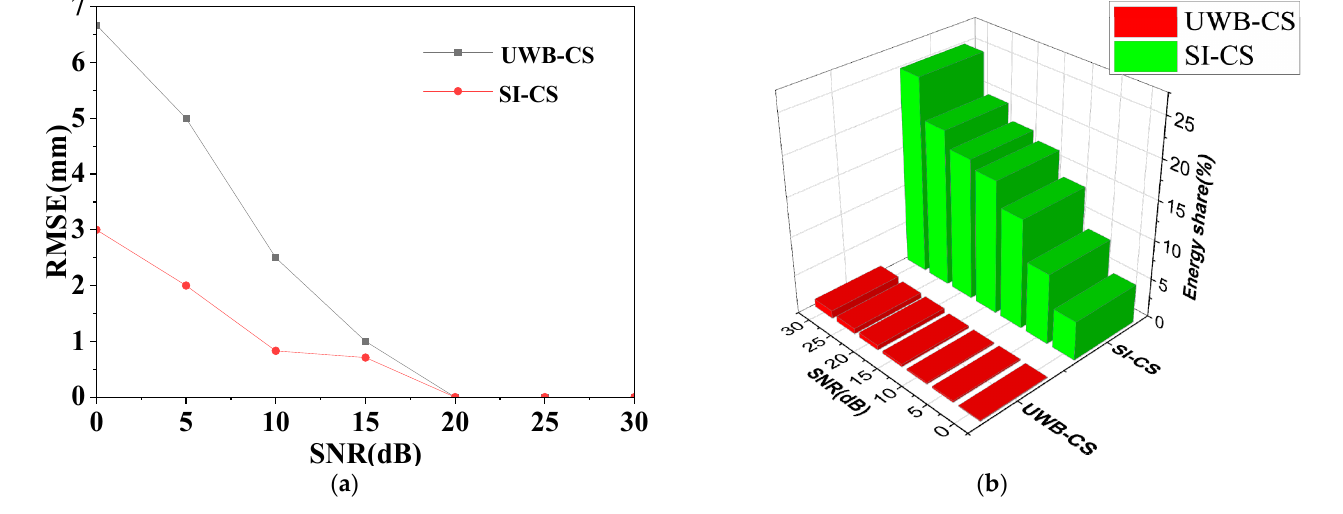
Figure 6. The trend of the peak in the lateral direction at the PIM source location for the UWB-CS method and the SI-CS method.